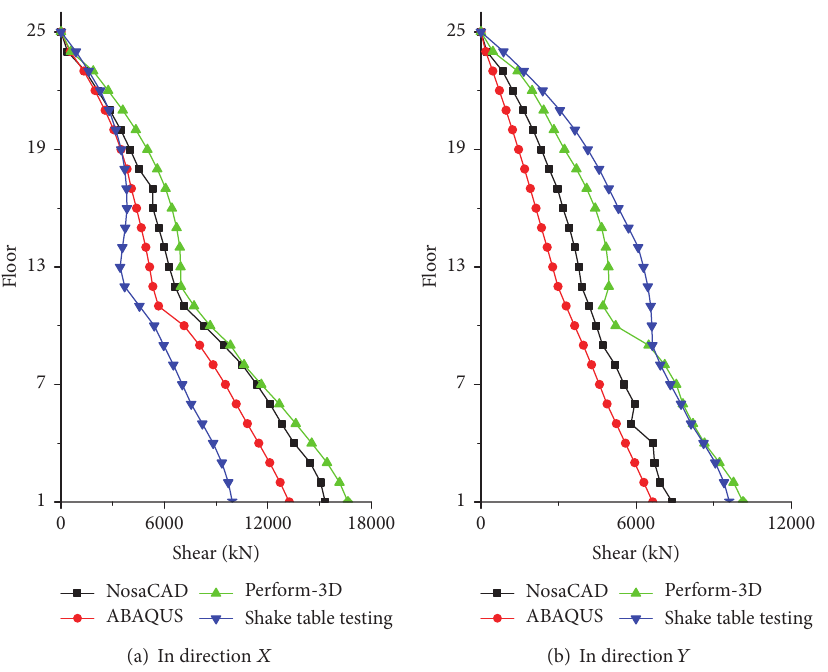
Figure 21: Story shear envelopes of frequent intensity 7